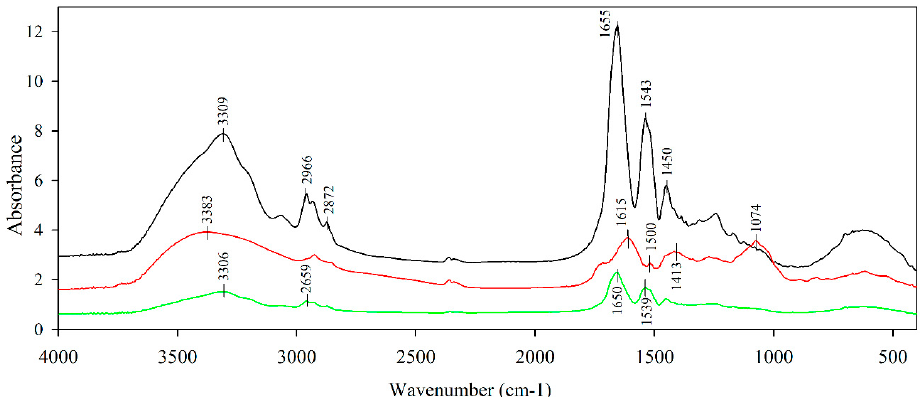
Figure 2. FTIR spectra of: electrosprayed zein particles, ZNe (black line); açaí extract, AÇ EXT (red line); and electrosprayed zein particles containing açaí, ZN/AÇ EXT (green line).